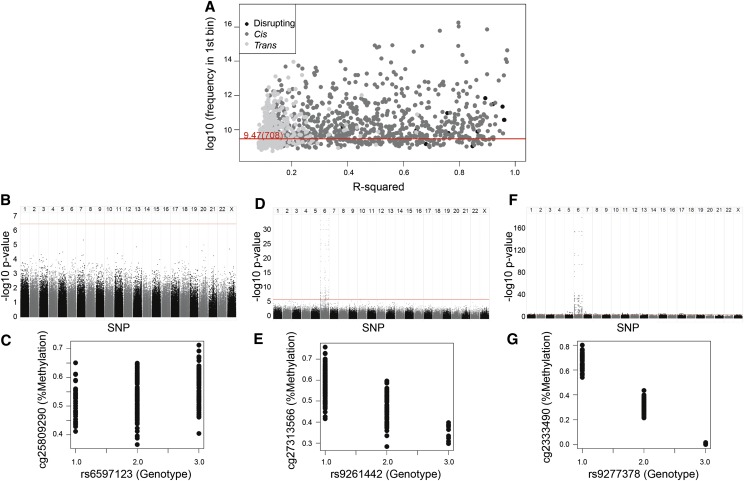
(A) The strength of association between genotype and methylation levels is a continuum, with most VMR-CpGs showing some association with genotype. Scatter plot of Pearson R2 (x-axis) for the VMR-CpG and best SNP match against log2 of the number of regression P-values in the first bin of 1000 equally distributed bins (y-axis); the red line represents an absolutely even 708 regression P-value in the first bin. (Black) Disrupting pairs, (dark gray) cis pairs, (light gray) trans pairs. (B) Some VMR-CpGs are minimally influenced by genotype. Manhattan plot of methylation at one VMR-CpG against all SNPs (x-axis) with −log10
P-value on the y-axis, as an example of VMR-CpG with low R2 and a low number of P-values in the first bin. (C) Scatter plot of genotype (x-axis) against methylation (y-axis) for the top pair from the same VMR-CpGs as in B. (D) Some VMR-CpGs are moderately influenced by genotype. Manhattan plot of methylation at one VMR-CpG against all SNPs (x-axis) with −log10
P-value on the y-axis, as an example of VMR-CpG with moderate R2 and a moderate number in the first bin. (E) Scatter plot of genotype (x-axis) against methylation (y-axis) for the top pair from the same VMR-CpGs as in D. (F) Manhattan plot of CpG against all SNPs (x-axis) with −log10 of the P-value (y-axis), as an example of VMR-CpG with high R2 and a high number in the first bin. (G) Scatter plot of genotype (x-axis) against methylation (y-axis) for the top pair from the same CpG as in F.